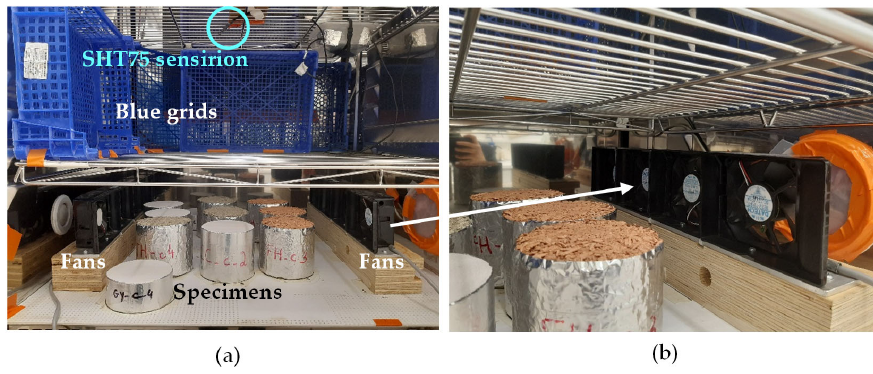
Figure 2. MBV experimental setup: ( a ) air velocity control; ( b ) fans.